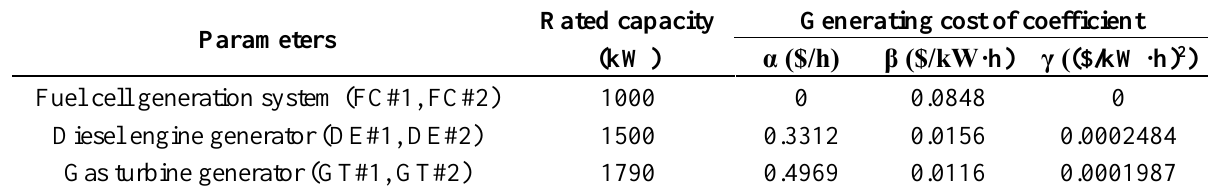
Table 2. Parameters of the DGs.